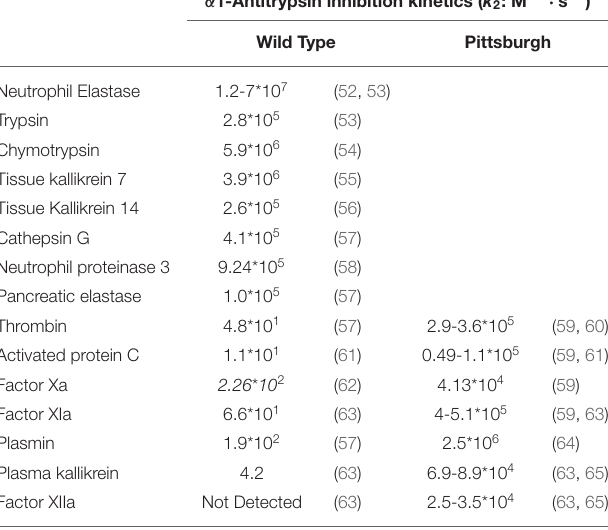
TABLE 1 | The Pittsburgh (M358R) mutation dramatically alters α 1-antitrypsin